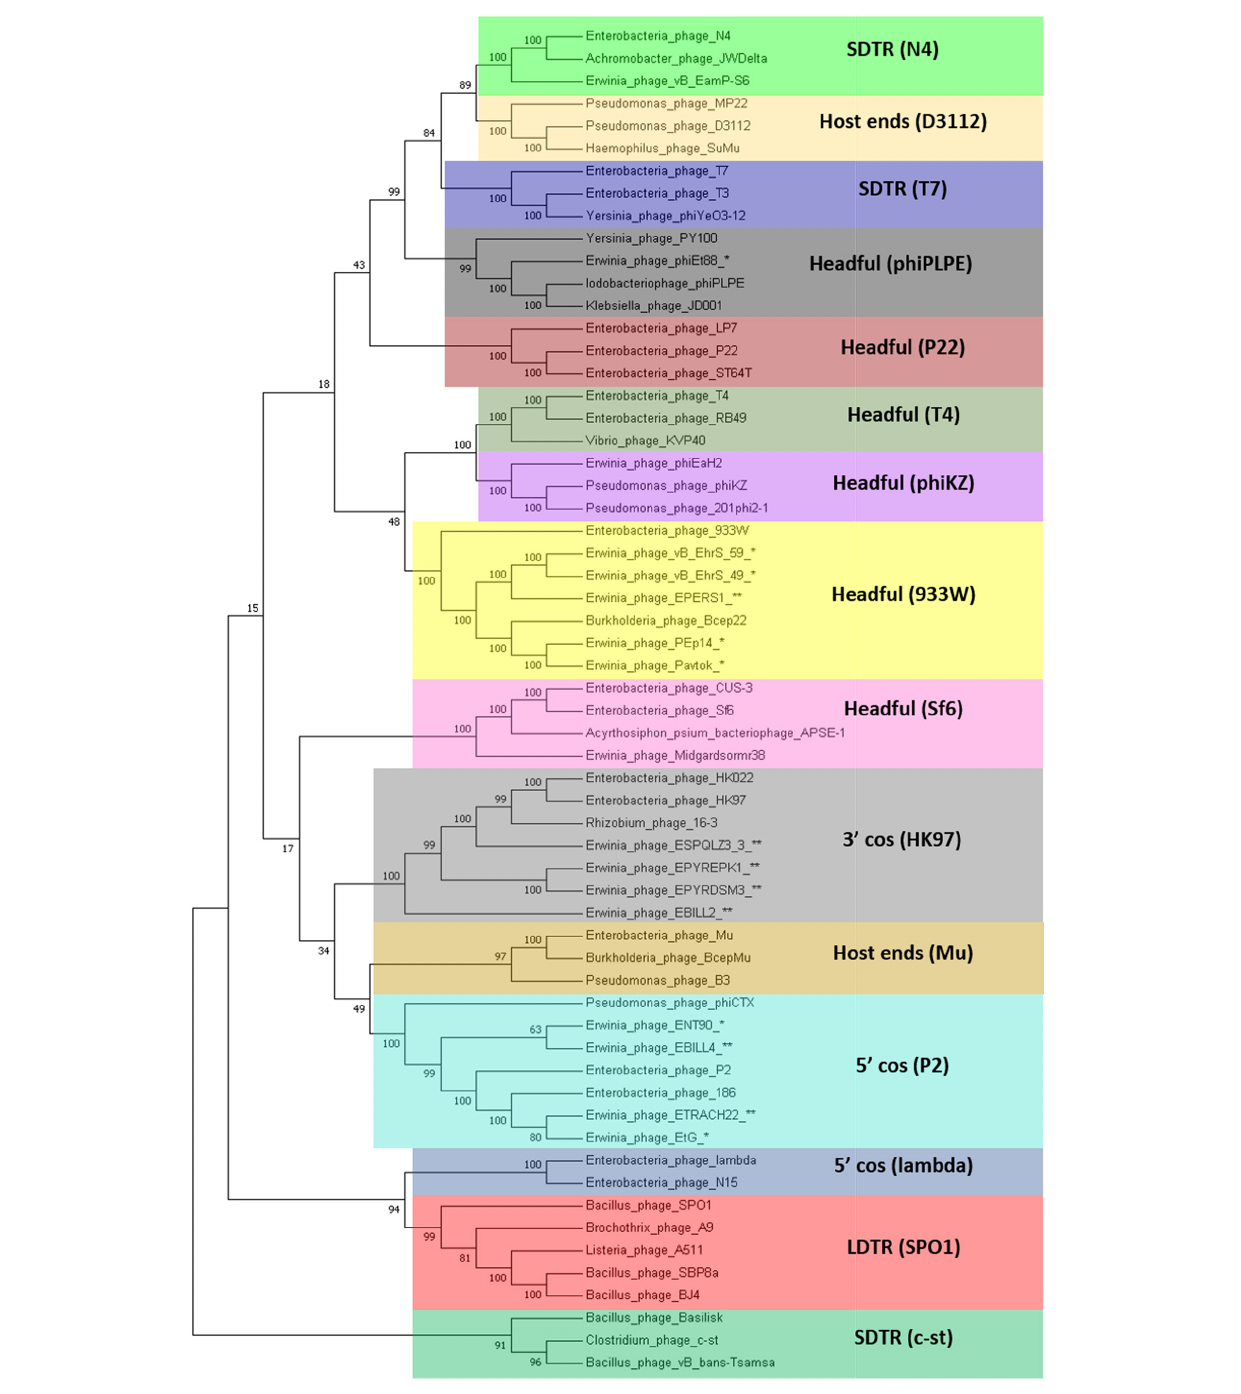
FIGURE 4 | Terminase large subunit protein neighbor-joining tree. The evolutionary history was inferred using the neighbor-joining method (Saitou and Nei, 1987). The bootstrap consensus tree inferred from 1000 replicates is taken to represent the evolutionary history of the taxa analyzed. The percentage of replicate trees in which the associated taxa clustered together in the bootstrap test (1,000 replicates) is shown next to the branches (Felsenstein, 1985). The evolutionary distances were computed using the method of the number of differences (Nei and Kumar, 2000) and are in the units of the number of amino acid differences per sequence. The analysis involved 60 amino acid sequences. All positions with less than 90% site coverage were eliminated. That is, fewer than 10% alignment gaps, missing data, and ambiguous bases were allowed at any position. There were a total of 385 positions in the final dataset. Evolutionary analyses were conducted in MEGA7 (Kumar et al., 2016). Colored rectangles represent groups of phages that employ the same packaging strategy. Asterisk indicates TerL sequence of a known temperate Erwinia phage. Double asterisk indicates TerL sequence of a prophage derived from the bacterial chromosome of Erwinia sp. LDTR stands for long direct terminal repeats, SDTR for short direct terminal